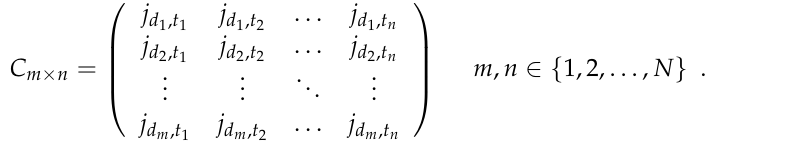
Figure 3. Target matching.